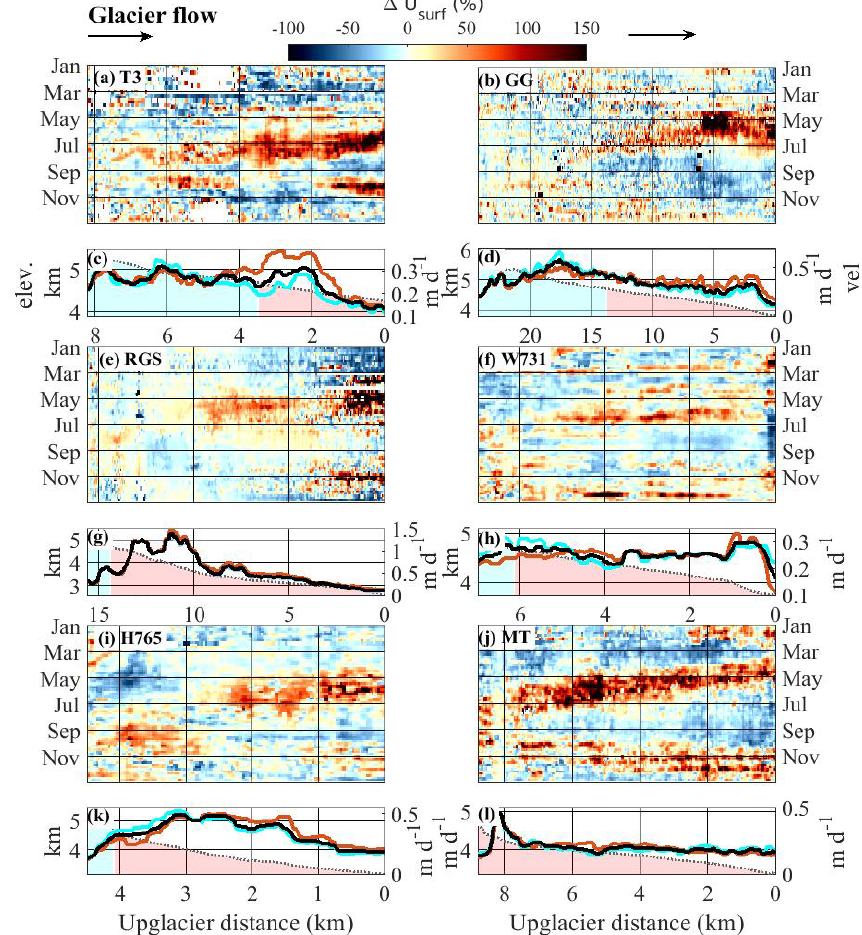
Figure 4. Annual pattern of glacier velocity changes relative to the annual median velocity along the flowline of the selected glaciers in Fig. 1a (green lines; except for the Fedchenko Glacier). Changes are expressed in percent to the annual median velocity for panels (a) , (b) , (e) , (f) , (i) and (j) . (a, c) Tanymas 3 Glacier; (b, d) Grumm-Grzhimaylo Glacier; (e, g) Russian Geographical Society Glacier; (f, h) Walter 731 Glacier; (i, k) Hadyrsha 765 Glacier; (j, l) Malyy Tanymas Glacier. The 7-year median annual (black), summer (brown) and winter (cyan) velocity along the flowline is shown below each glacier (in md − 1 ; right axis). Glaciers flow from left to right (black arrow). Light gray line shows the elevation profile (in km; left axis), with the blue area located above the ELA and the red area under the ELA. The color bar is the same for all glaciers. It is coded on a linear scale from blue (slower than the median velocity) to red (faster than the median